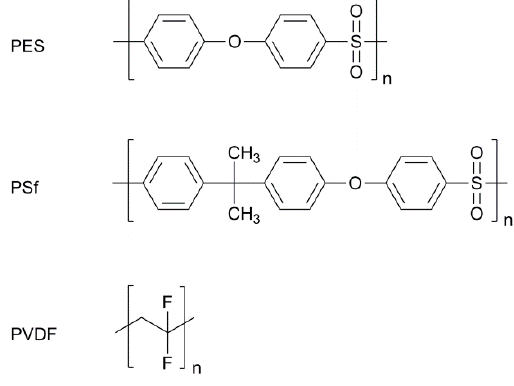
Figure 1. Typical membrane polymers.